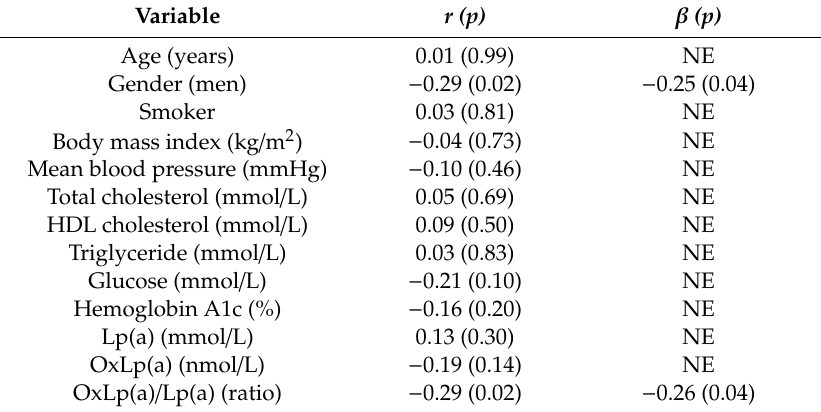
Table 2. The correlation between the variables and reactive hyperemia index.